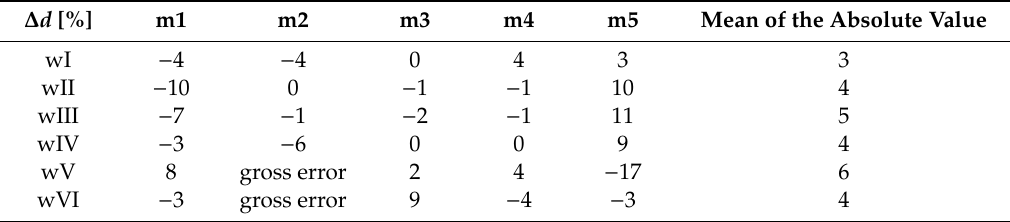
Table 12. Relative thickness determinations error after correction of dielectric